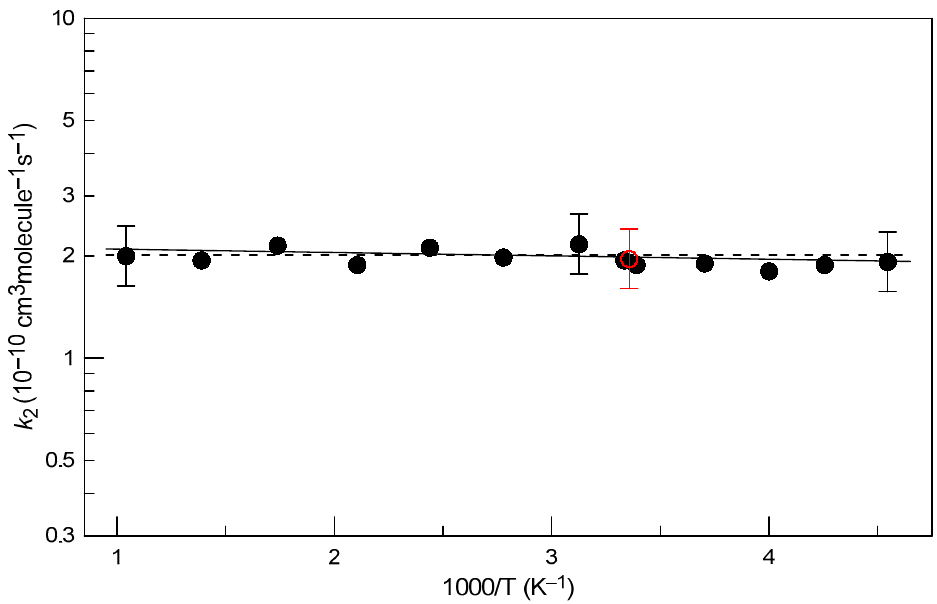
Figure 7. Temperature dependence of k 2 : open red circle, Schölne et al. [12]; filled circle, this work. Uncertainties shown for selected present measurements of k 2 correspond to 20%.